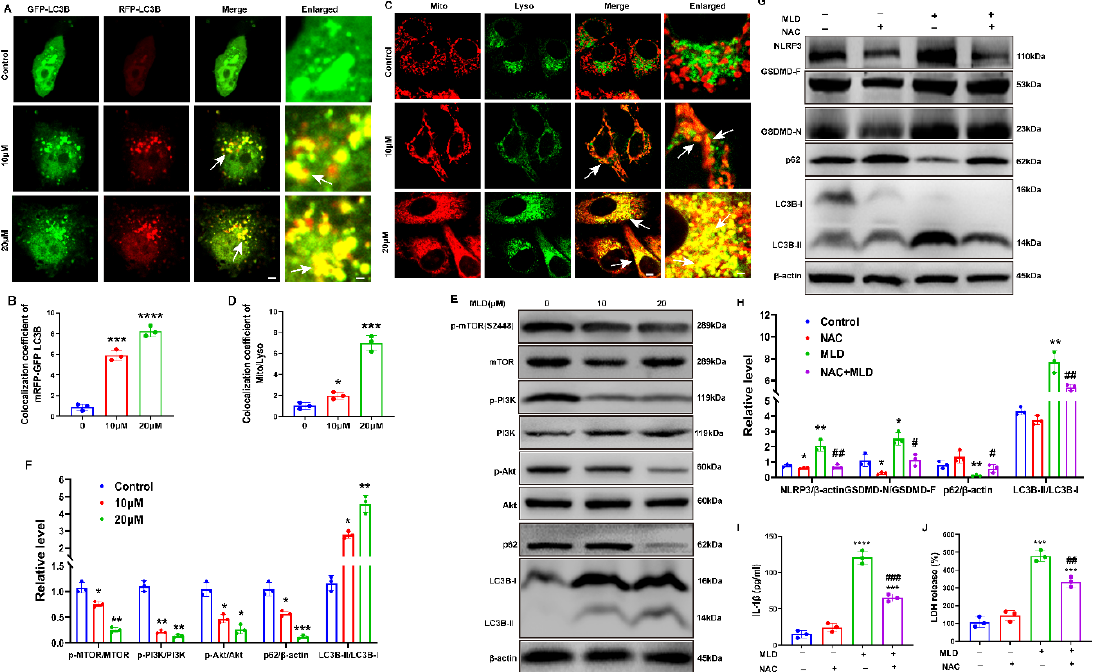
Figure 5. MLD induced HepG2 cell mitophagy by inhibiting PI3K/AKT/mTOR pathway. ( A ) Con- focal detection of HepG2 cells transfected with mRFP-GFP-LC3B plasmid. Scale bar: 25 μ m and 5 μ m in merge and enlarged, respectively. Arrow: the colocalization of GFP-LC3B and RFP-LC3B. ( B ) Colocalization area statistics in A. ( C ) Mito staining and Lyso staining were used to analyze the fusion of mitochondria and lysosomes in HepG2 cells treated with MLD for 24 h. Scale bar: 25 μ m and 5 μ m in merge and enlarged, respectively. Arrow: the colocalization of mitochondria and lysosome. ( D ) Colocalization area statistics in C. ( E ) Levels of the PI3K, p-PI3K, AKT, p-AKT, mTOR, p-mTOR, P62, and LC3B proteins in the different groups were analyzed by Western blotting. ( F ) The quantitative analysis of relative protein levels of E. ( G ) Levels of the NLRP3, GSDMD, p62, and LC3B after treatment with MLD (20 µ M) in the presence or absence of NAC (5 mM) for 24 h were measured by Western blotting. ( H ) The quantitative analysis of relative protein levels of G. The levels of IL-1 β ( I ) and LDH ( J ) after treatment with MLD (20 µ M) in the presence or absence of NAC (5 mM) for 24 h were measured by ELISA. The results are representative of three independent experiments and are expressed as the mean ± SD. * p < 0.05, ** p < 0.01, *** p < 0.001, and **** p < 0.0001 compared